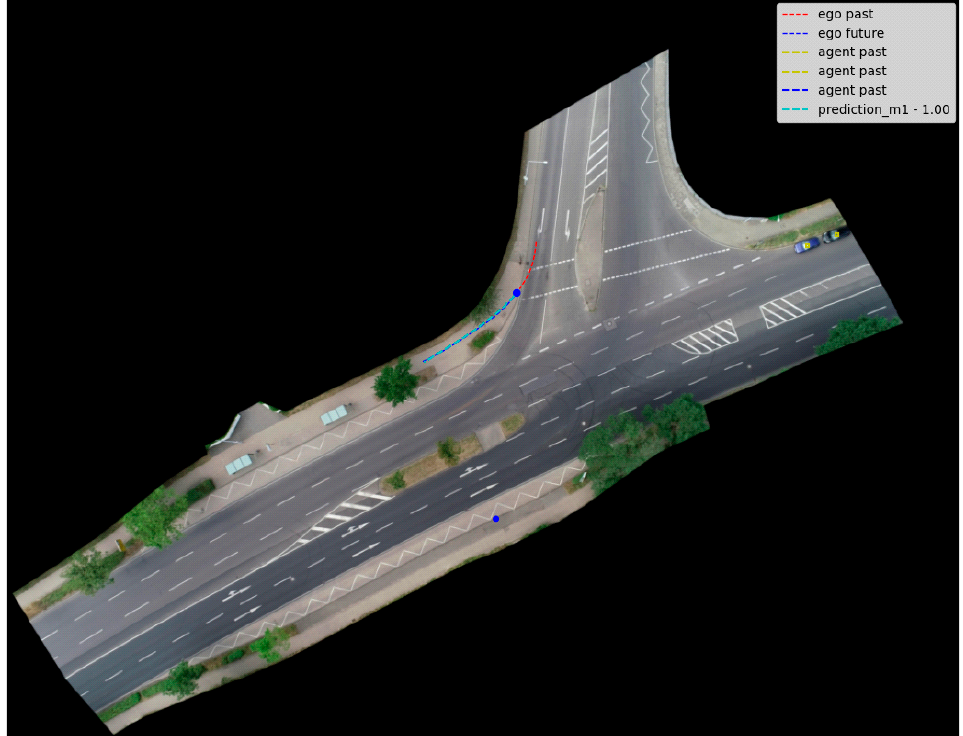
Figure 14. Traffic scene prediction with the unimodal approach. In this scenario, the bicyclist is going to the sidewalk part of the road.